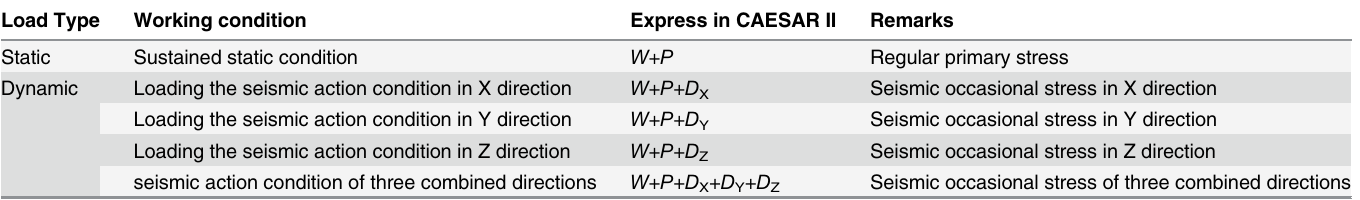
Table 7. Instruction for working condition combinations.